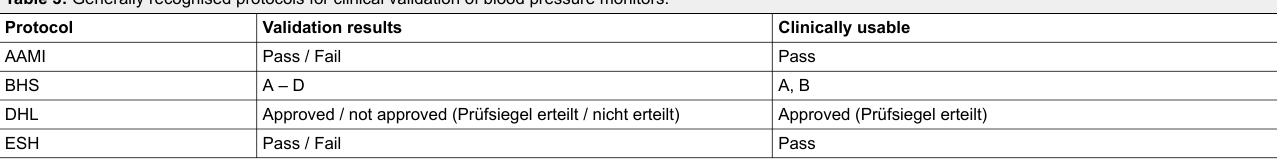
Table 3: Generally recognised protocols for clinical validation of blood pressure monitors.